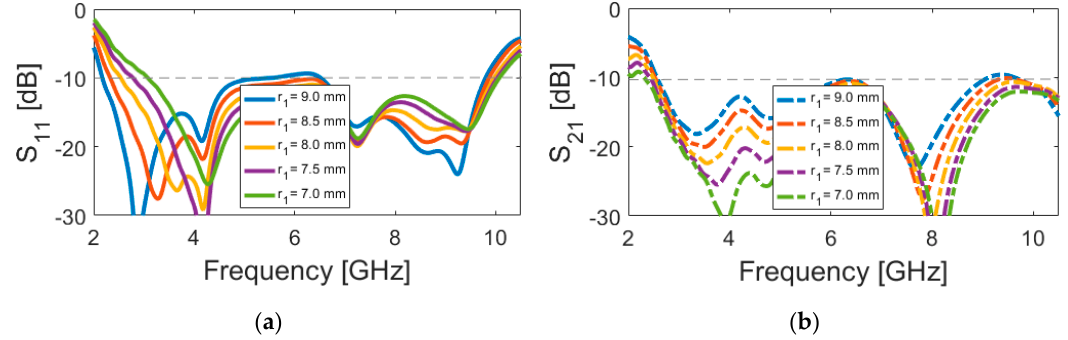
Figure 7. ( a ) S 11 and (b ) S 21 characteristics for di ff erent values of r 1